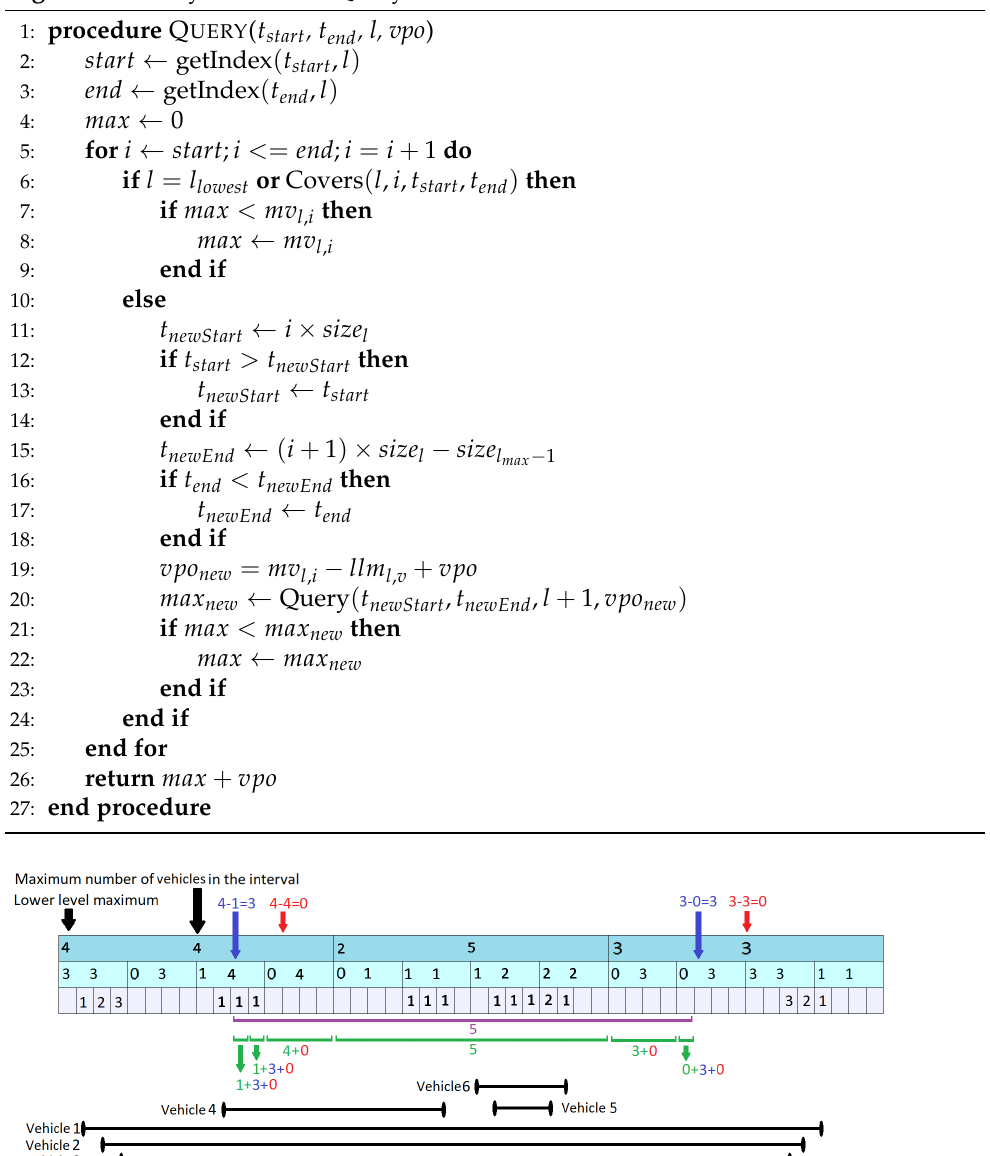
Algorithm 3 KaryIntervalTreeQuery